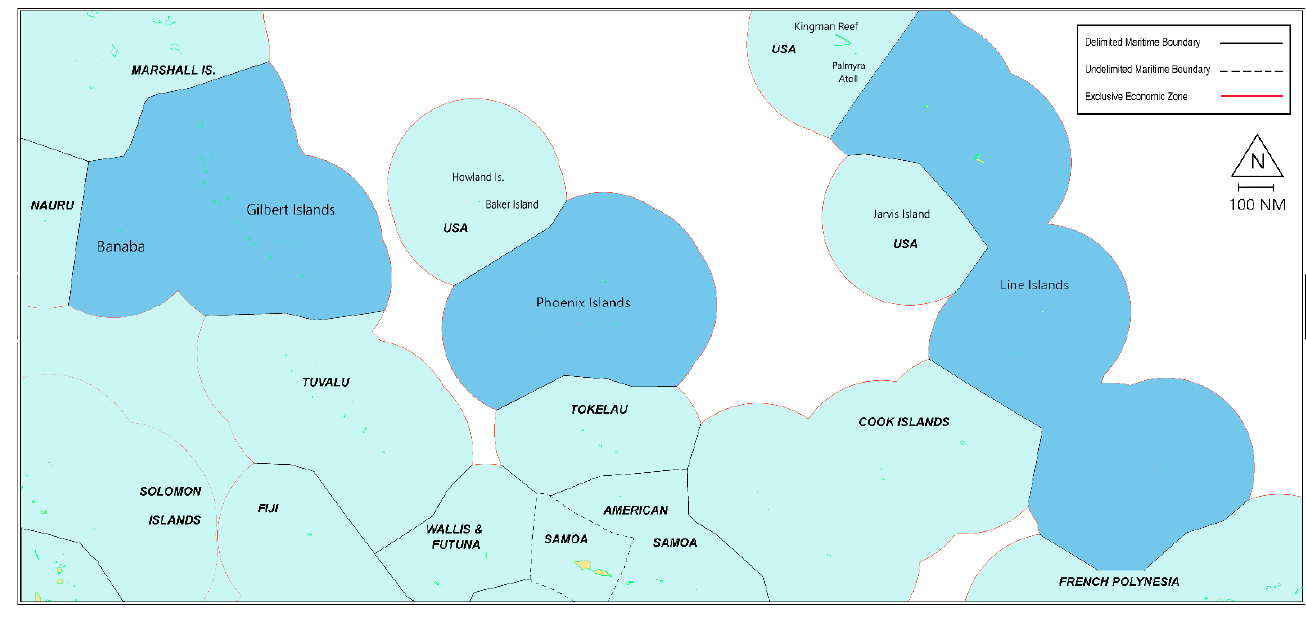
Figure 12. Location of Kiribati’s atolls and islands, including claimed EEZ areas and boundaries.